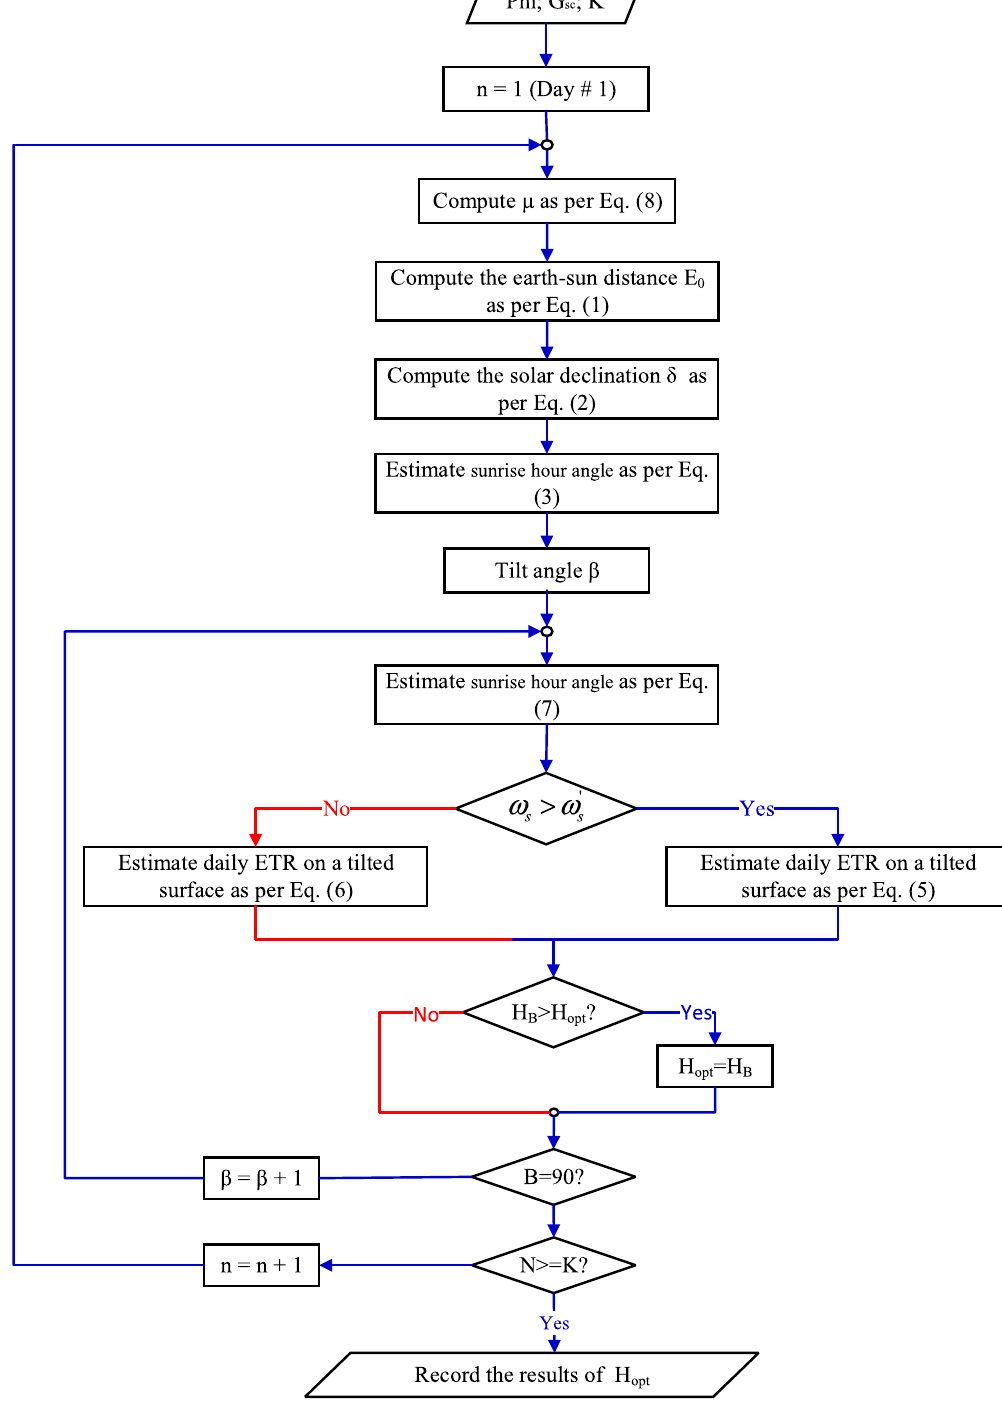
Figure 5. Computation of the OTA β for a specified interval